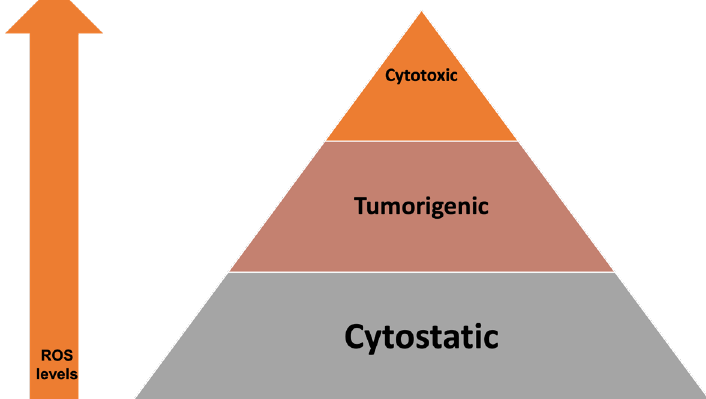
Figure 7. Impact of intracellular ROS levels on cell